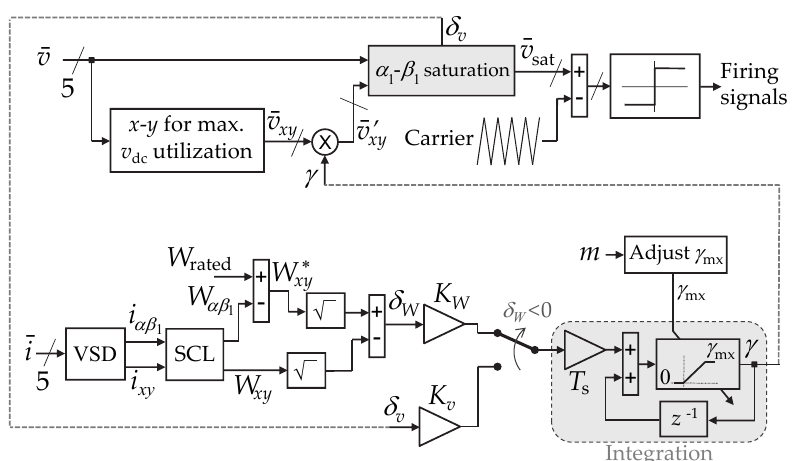
Figure 29. Overmodulation method with adaptive x - y current limitation proposed in [143] for n = 5 to provide minimum α 1 - β 1 distortion while preventing excessive x - y current. T s is sampling period, W rated is rated SCL, W αβ is α 1 - β 1 SCL, W xy is x - y SCL, and W ∗ xy is the maximum allowable x - y SCL 1 (depending on W rated and W αβ ) 1